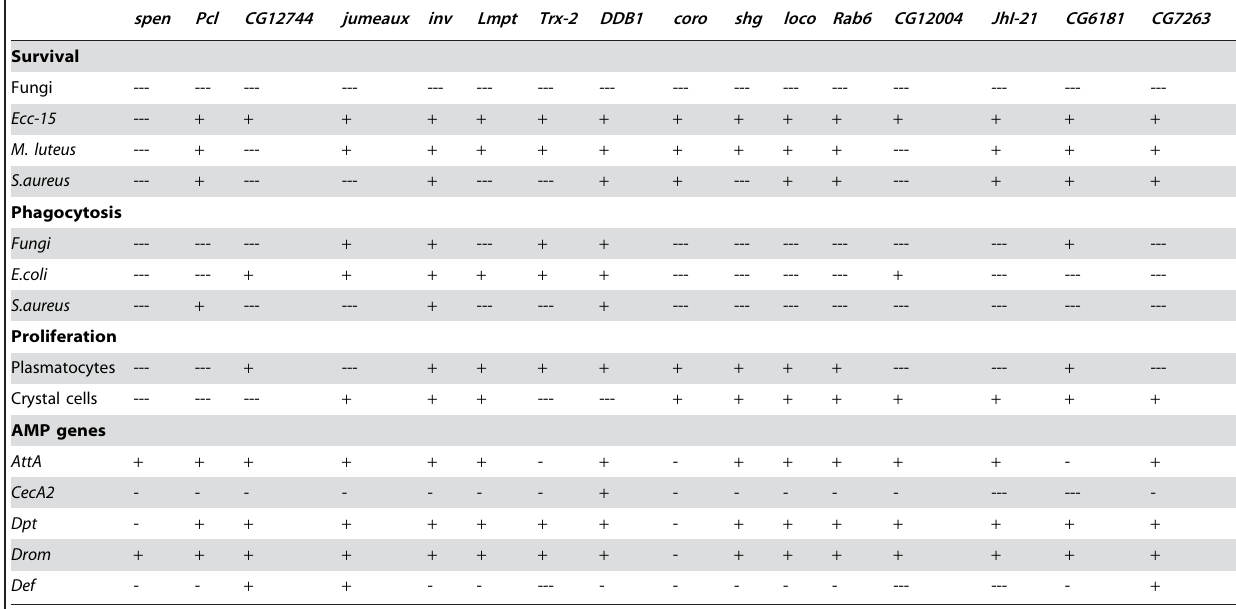
Table 1. Summary of the cellular and humoral immune responses of the sixteen